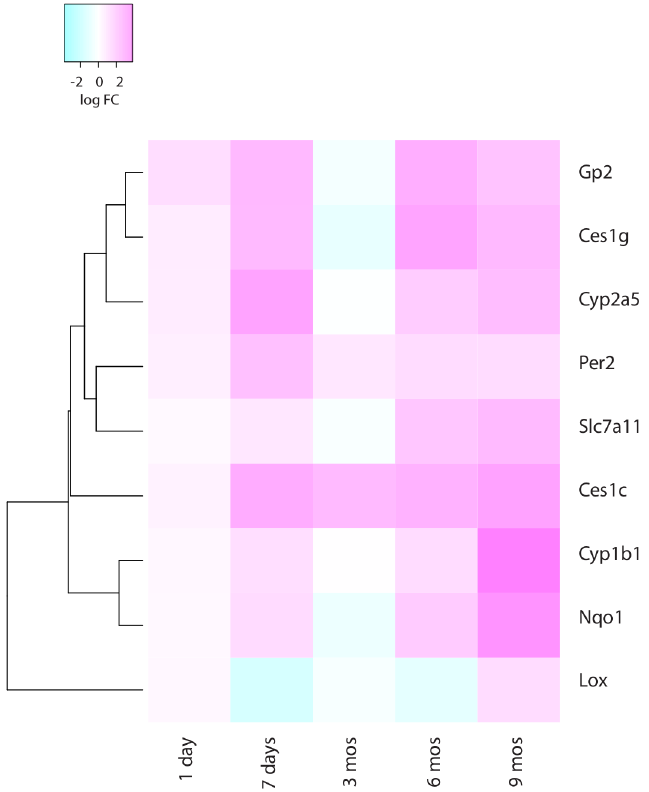
Fig 2. Heatmapof the relative change in gene expression. Log2FC in CS-exposed mice comparedto AC mice of the 9 genesfound to statistically significantly differentially expressedat four of five time points (FDR (cid:20) 0.10). Positive fold change(pink) indicatesupregulation in CS-exposedmice; negative fold change (blue) indicatesdownregulation in CS-exposedmice.